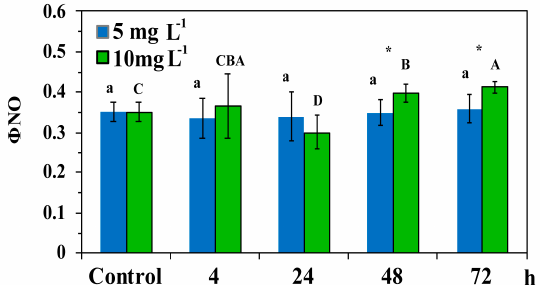
Figure 6. The quantum yield of non-regulated energy dissipated in PSII (non-regulated heat dissipation, a loss process due to PSII inactivity) ( Φ NO ) in control leaf blades of C. nodosa ( Cymodocea nodosa ) and in leaf blades exposed to 5 mg L − 1 and 10 mg L − 1 ZnO NPs for 4 h, 24 h, 48 h and 72 h. Symbol explanations as in Figure 5.